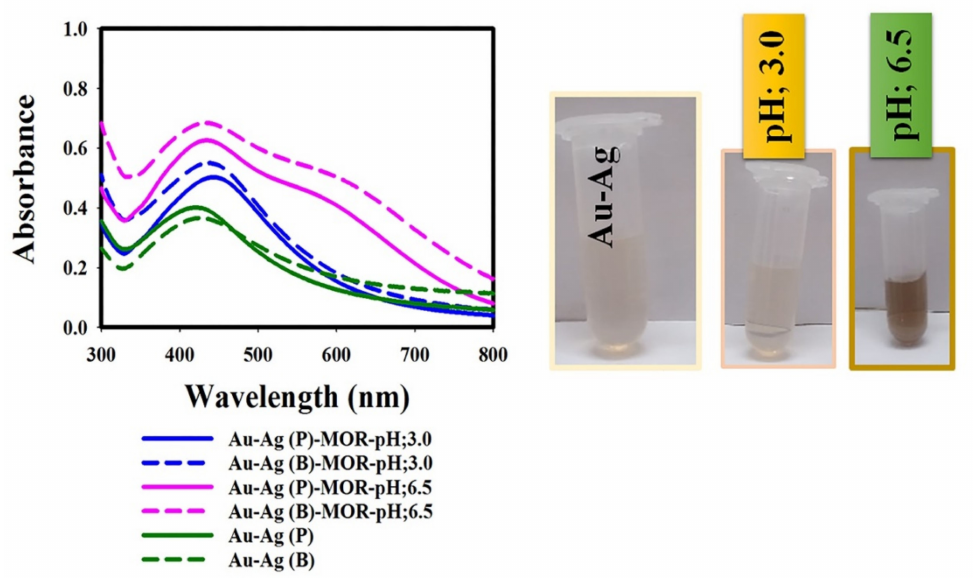
Figure 6. UV-visible absorption spectra of Au@Ag NPs upon addition of MOR solution at different pH. (Photographic images from left to right: Au@Ag NPs + 0 µ g/mL (blank), Au@Ag NPs + 70 µ g/mL MOR at different pH, incubation time 5